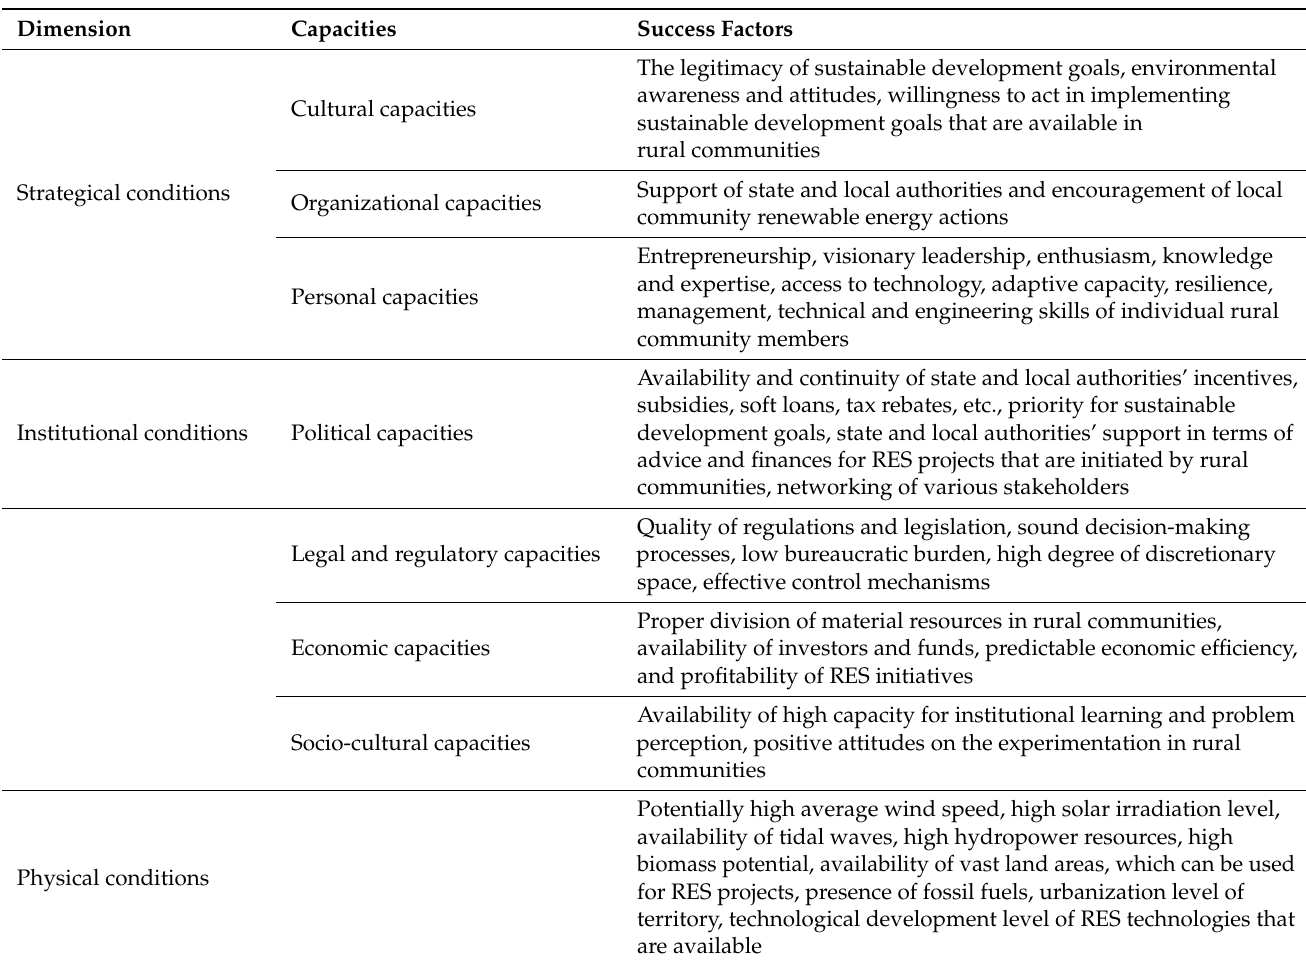
Table 3. Success factors of community RES initiatives in rural